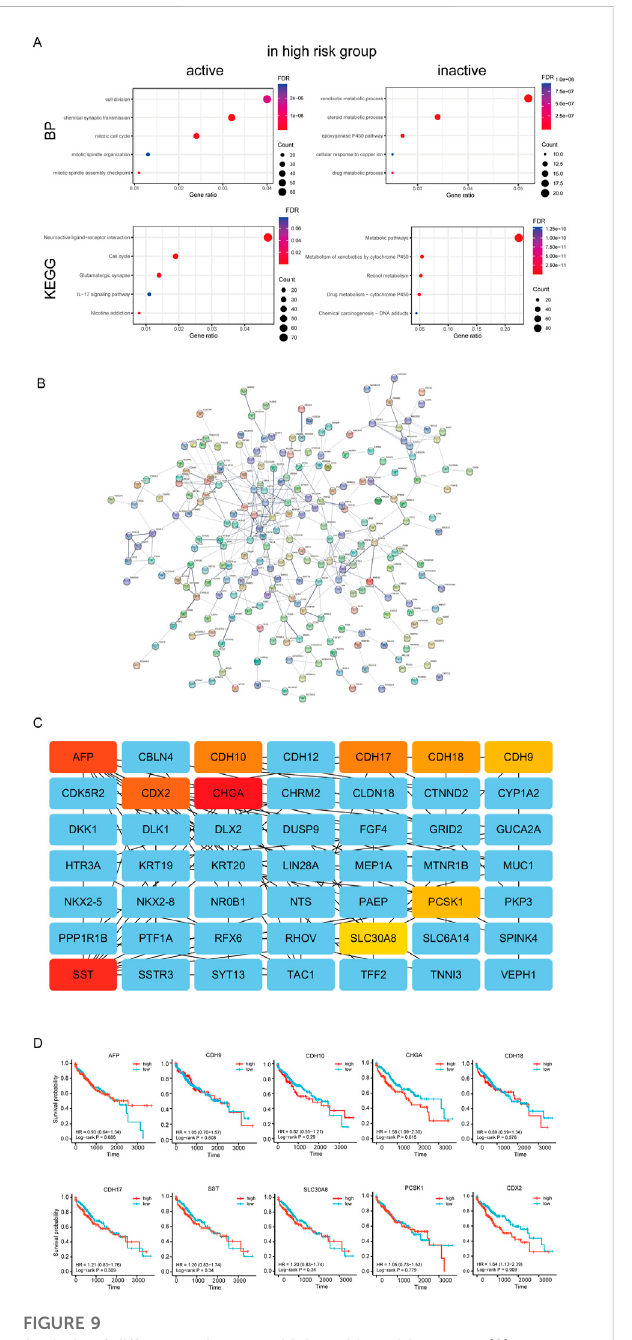
FIGURE 9 Analysis of differences between high and low risk groups. (A) Enrichment analysis between high and low risk groups. (B) PPI network of the differential expressed genes of high and low risk groups. (C) Hug genes ofPPI network between highand low risk groups (D) Survival curve of hub genes. fi nds HCC patients with EZH2 high expression have low survival rates. G6PD is a rate-limiting enzyme in the pentose phosphate pathway, and its de fi ciency accelerates cellular senescence (Ho et al., 2000). Whereas, high expression of G6PD promotes tumor growth by generating ribo-5-phosphate and NAPDH (Stanton, 2012). G6PD is reported to induce epithelial-mesenchymal transition, thereby promoting HCC cell invasion (Lu et al., 2018). In addition, G6PD